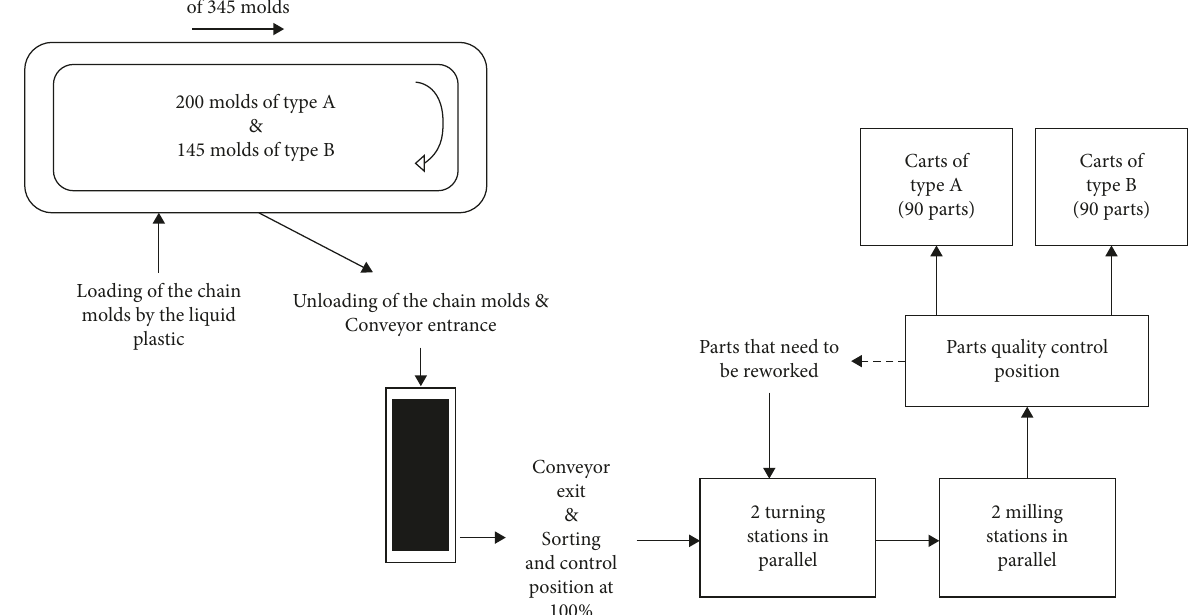
Figure 3: Simplified diagram of the manufacturing process of plastic parts of types A and B within the factory’s